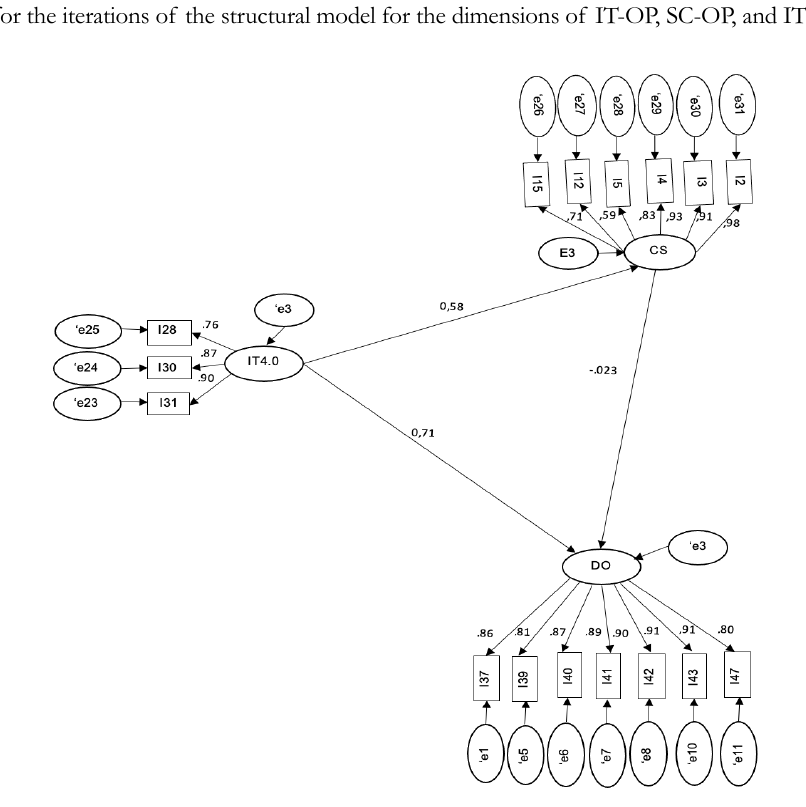
Figure 2. SEM of the relationship between Industry 4.0